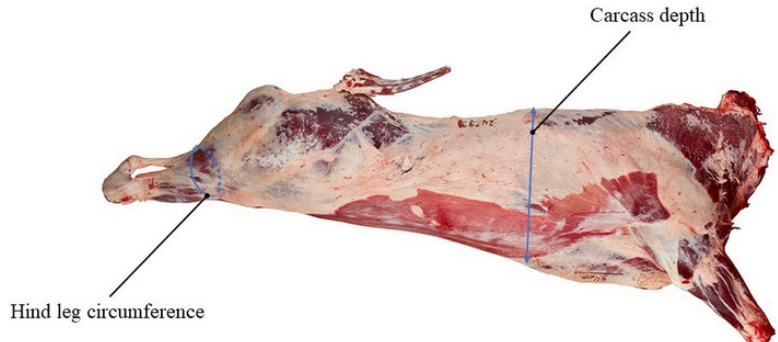
Figure 1. Measurement of hind leg circumference and carcass depth. Table 1. Mean carcass depth and hind leg